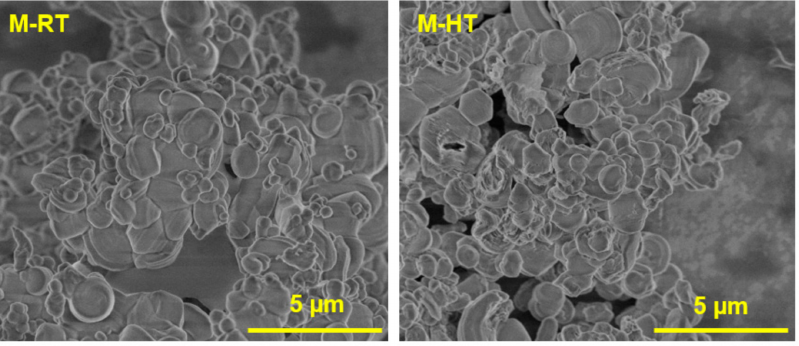
Figure 9. SEM images of the [CTA]-MCM-41 hybrid silicas.